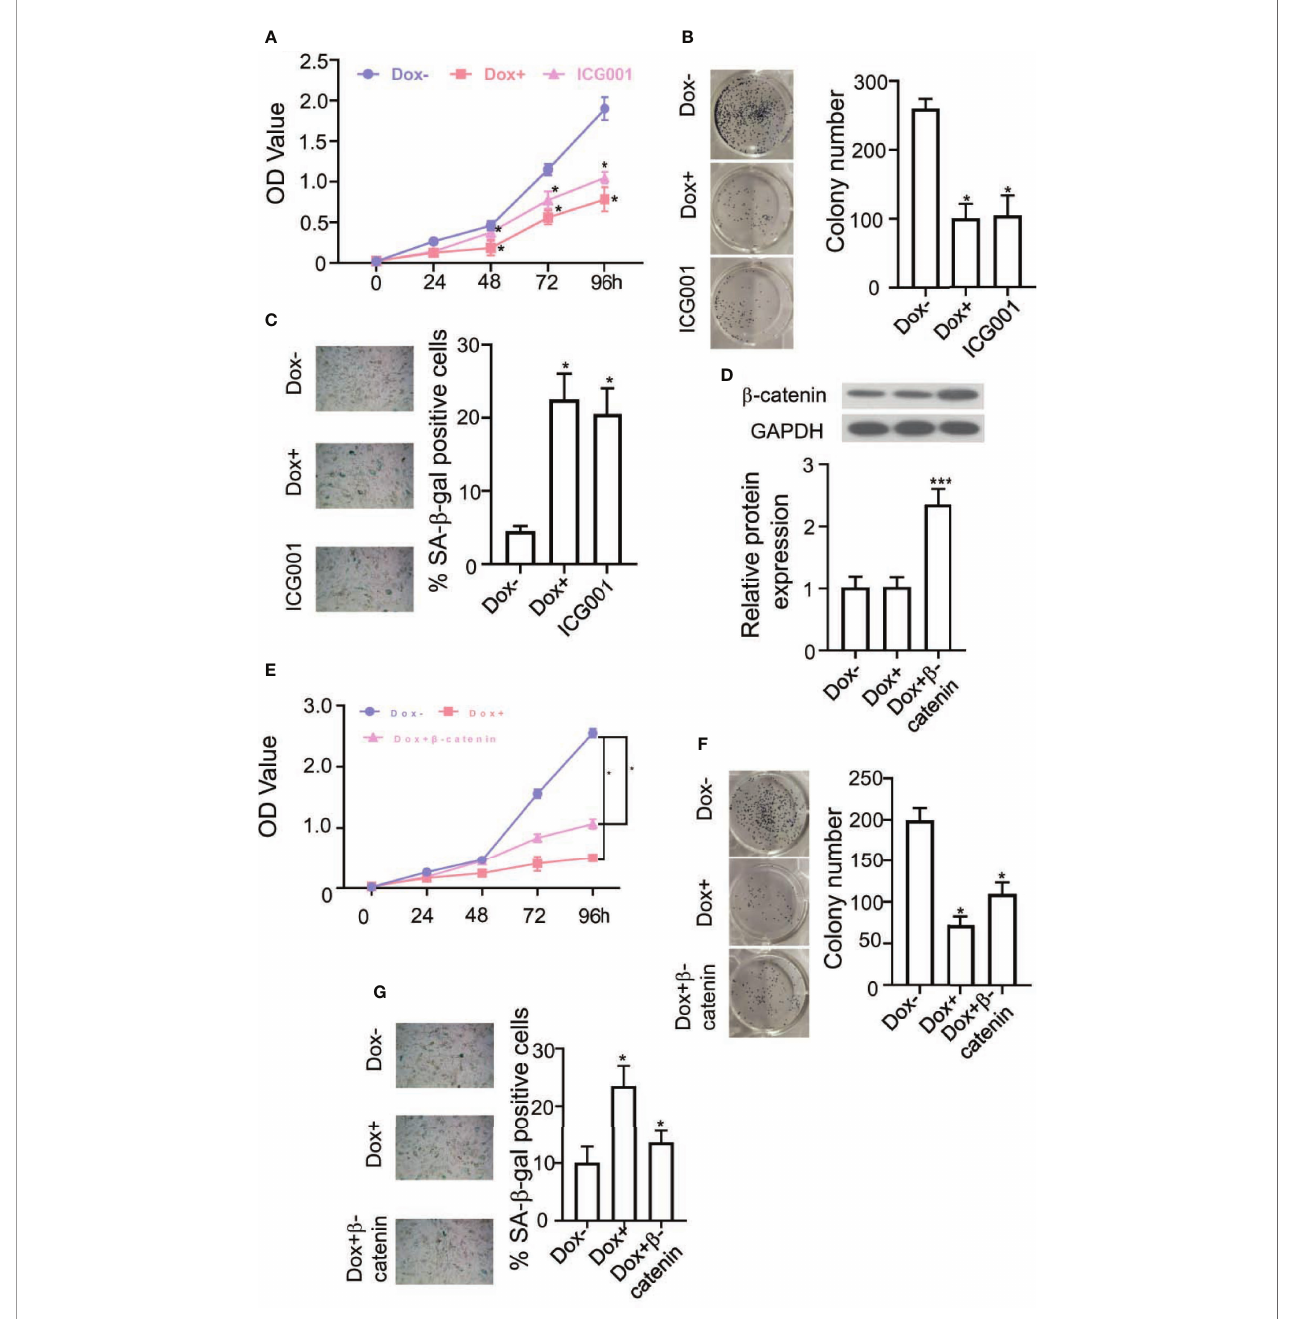
FIGURE 5 | b -catenin reverse the ZNF24 effect of BCPAPi cells. (A, B) Cell viability and colony forming dectection of BCPAPi cells without or with DOX (1 µg/ml) or ICG001 (0.1 m g/ml) treatment. (C) ICG001 induces senescence of BCPAPi cells. BCPAPi cells without or with DOX (1 µg/ml) or ICG001 (0.1 m g/ml) treatment for 48 h, later the aging cells were measured through activity of aging-related b -galactosidase (left) and the corresponding statistics (right). (D) b -catenin expression level detection by Western Blot assay. 0.1 m g b -catenin expression plasmids were transfected into BCPAPi cells (1 × 10 4 ), followed by DOX (1 µg/ml of DOX treatment or not, indicated antibodies were added during Western Blot assay. (E, F) Cell viability and colony forming dectection of BCPAPi cells. 0.1 m g b -catenin expression plasmids were transfected into BCPAPi cells (1 × 10 4 ), followed by 1 µg/ml of DOX treatment or not. (G) BCPAPi cells (1 × 10 4 ) were transfected with b -catenin expression plasmid (0.1 m g), followed by 1 µg/ml of DOX treatment or not. The aging cells were measured through the activity of aging-related b -galactosidase (left) and the corresponding statistics (right). Values are obtained from three independent assays, while unpaired t-test was used for analysis. Error bars=SD. *P < 0.05, *** P <